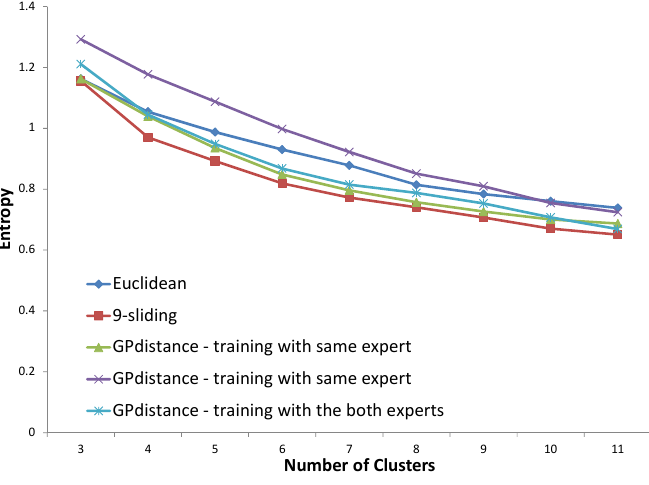
Figure 23. Entropy result for northern region using the data of expert #1.